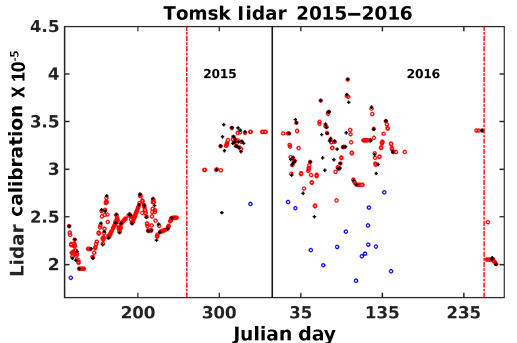
Figure 3. Time evolution from April 2015 to September 2016 of the lidar calibration factor (multiplied by 10 − 5 ). Dotted red lines correspond to major changes in lidar housing and expected change in calibration. Black crosses are for nocturnal profiles with molec- ular normalization at z r > 7km and aerosol two-way transmittance T 2 a > 0 . 89 (106 values out of 540). Red dots are for calibration in- terpolated from optimal conditions. Blue dots are for the few cases (20 out of 540) when calibration cannot be interpolated from opti- mal